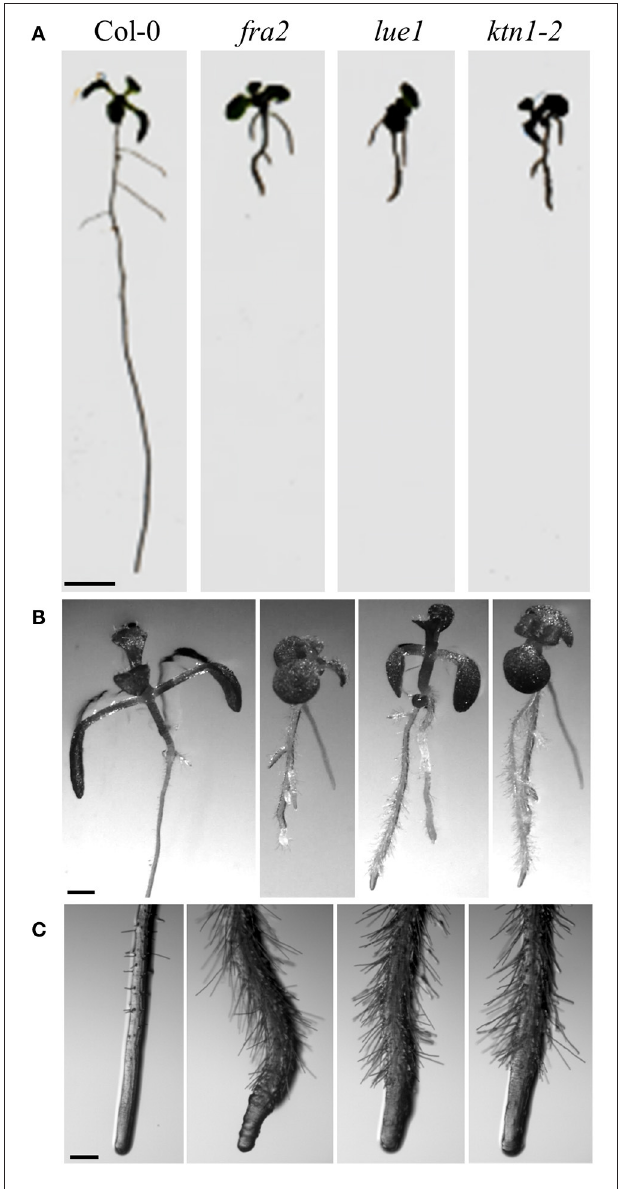
FIGURE 1 | Morphological phenotypes of KATANIN mutants vs. Col-0 wild-type (7 days old seedlings). (A) Representative pictures of whole Col-0 seedlings and KATANIN mutants. Note much shorter roots in the mutants. (B) Detailed pictures of above ground seedling parts in Col-0 and KATANIN mutants. (C) Detailed pictures of primary root tips of Col-0 and KATANIN mutants. Note radial expansion of mutant roots. Scale bars = 5mm (A) ; 1mm (B) ; 250 µ m (C)